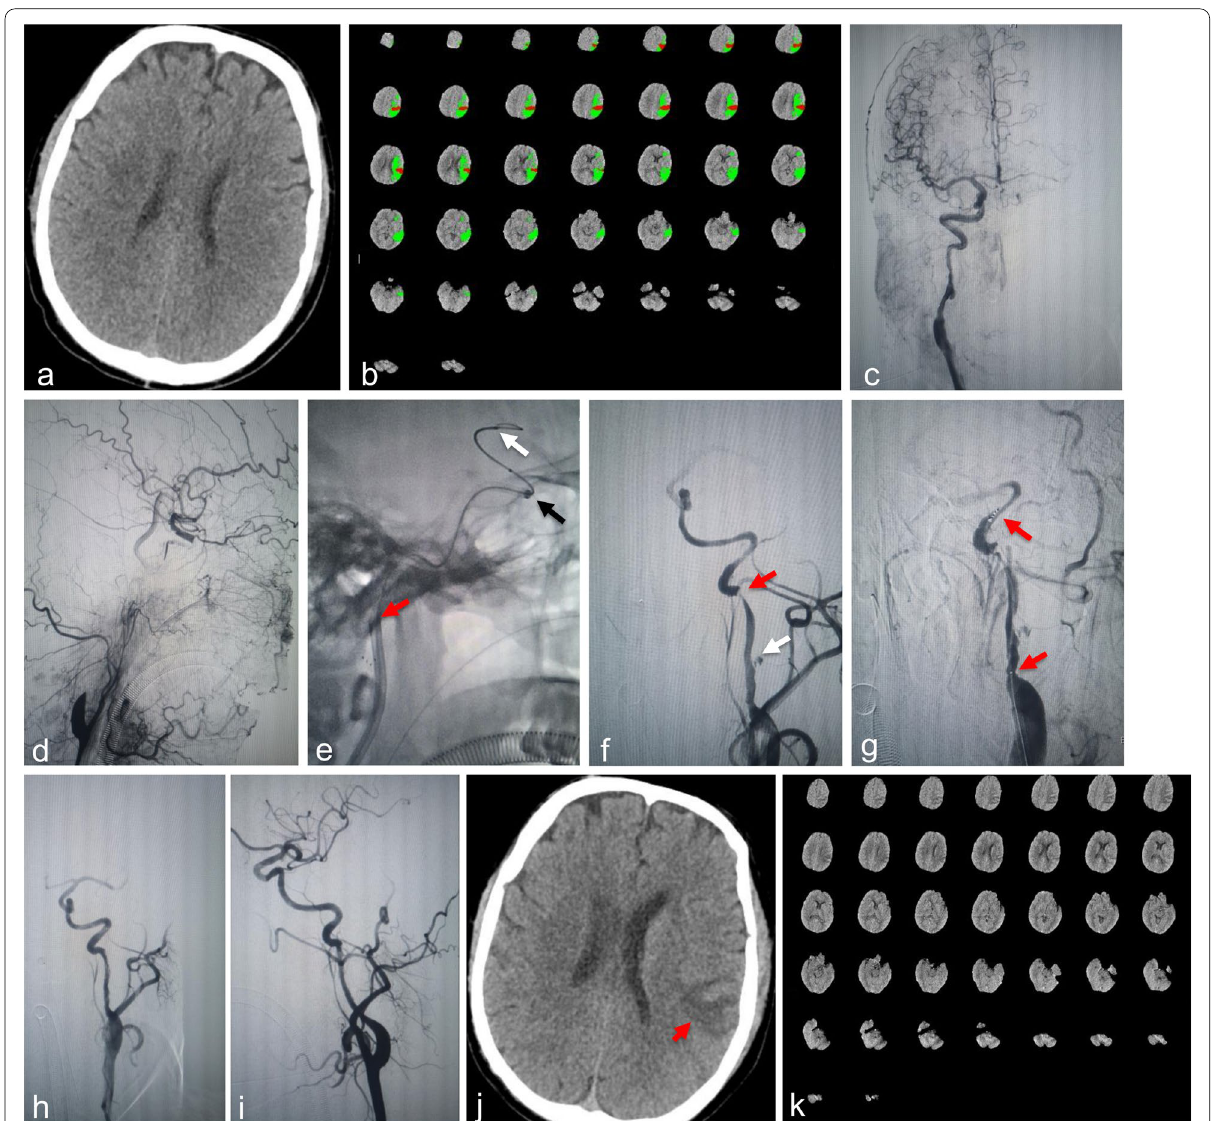
Fig. 2 The second procedure. a-b On Sep 9, 2020, emergent head NCCT showed no new lesion in the left hemisphere, and head CTP revealed a new core infarct of 18.2 mL in the left frontal lobe with an ischemic penumbral area of 100.4 mL in the left ICA supply area. c-i On Sep 9, 2020, an emergent EVT was performed. Preprocedural angiogram showed that the right ICA remained patent with residual moderate-to-severe stenosis and dissecting aneurysm and compensation to the left ACA and MCA via the ACom A (c), the left ICA was occluded distal to the bulb and manifested a flame sign with a refluxed flow to the C4 segment via the ophthalmic artery in the distal end (d); the position of the microcatheter tip (e. white arrow), the position of the CAT6 tip (e. black arrow), the position of the 8F guide catheter tip (e. red arrow); Applying with SCP technique, the left ICA was revascularized with a residual dissecting aneurysm (f. white arrow) and a red arrow indicated the key flow-limiting stenosis (f); red arrows indicated the distal and proximal markers of the 6 30 mm Solitaire FR stent (g); the P-A and oblique angiogram after stent detachment showed × that the stenosis was relieved and the dissecting aneurysm disappeared (h-i). j-k On Sep 14, 2020, repeated head NCCT showed that the new core infarct appeared in the left frontal lobe, and head CTP suggested that the perfusion of bilateral ICAs blood supply areas returned to